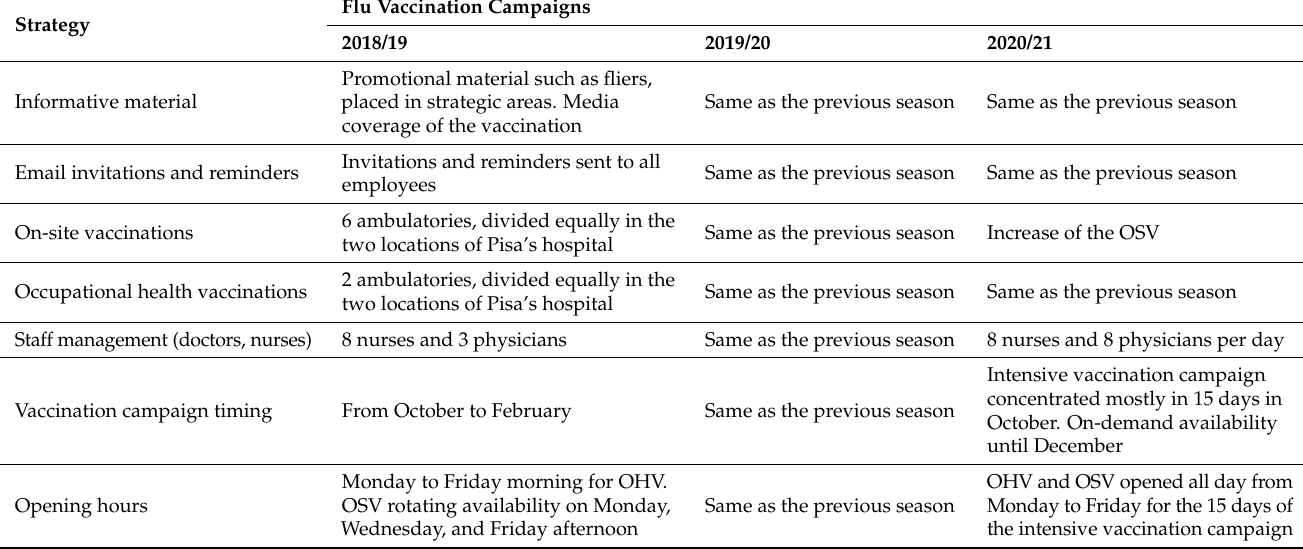
Table 1. Strategies implemented for the improvement of the Flu Vaccination Campaigns in the 2018/19, 2019/20 and 2020/21 flu